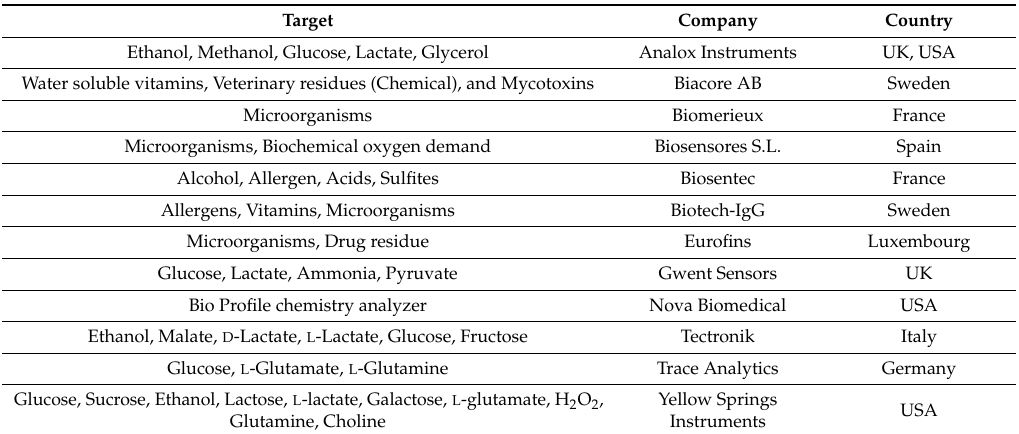
Table 4. Commercially available biosensors for food quality and